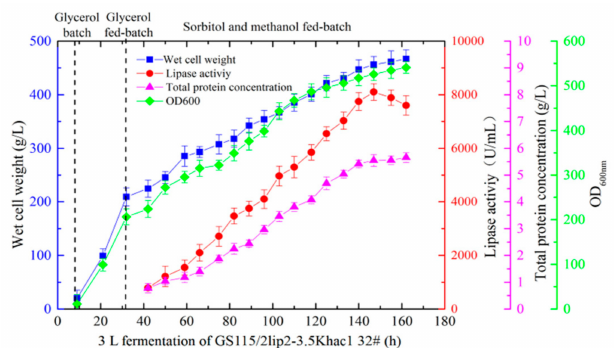
Figure 4. Wet cell weight, lipase activity, total protein concentration, and OD 600 during high-density fermentation of recombinant strain GS115 / 2lip2-3.5Khac1 #32 in a 3 L fermenter. Data are the mean ± standard deviation of triplicate experiments.